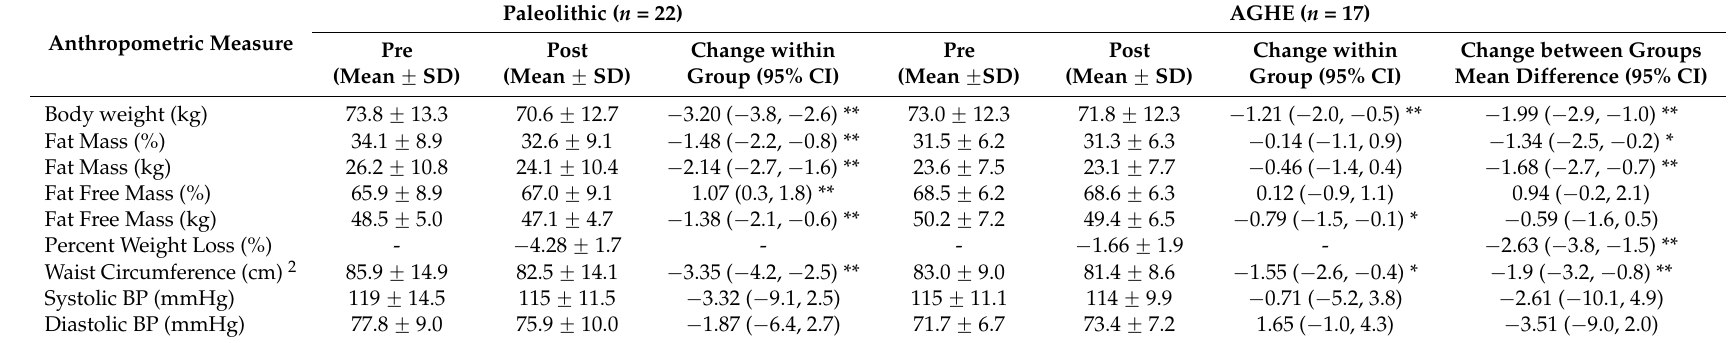
Table 1. Mean pre and post intervention anthropometric measurements, showing mean changes within and between groups 1